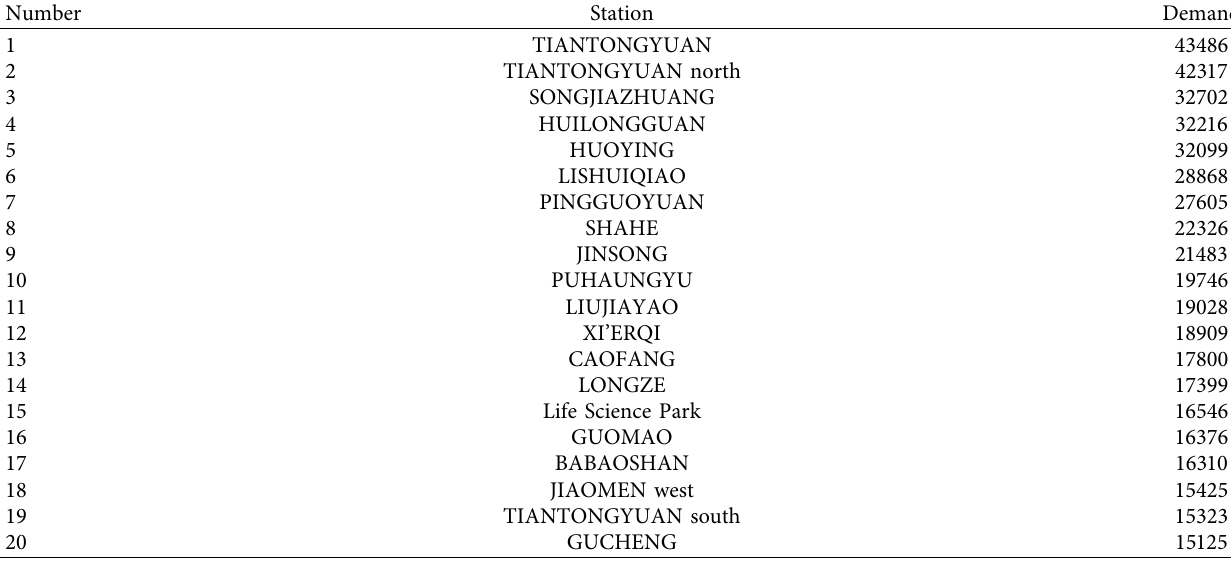
Table 2: Normalized inflow control stations with inflow demand (top 20).